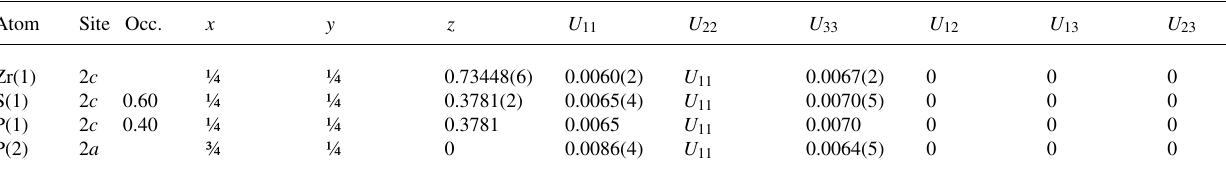
Table 2. Atomic coordinates and displacement parameters (in Å 2 )